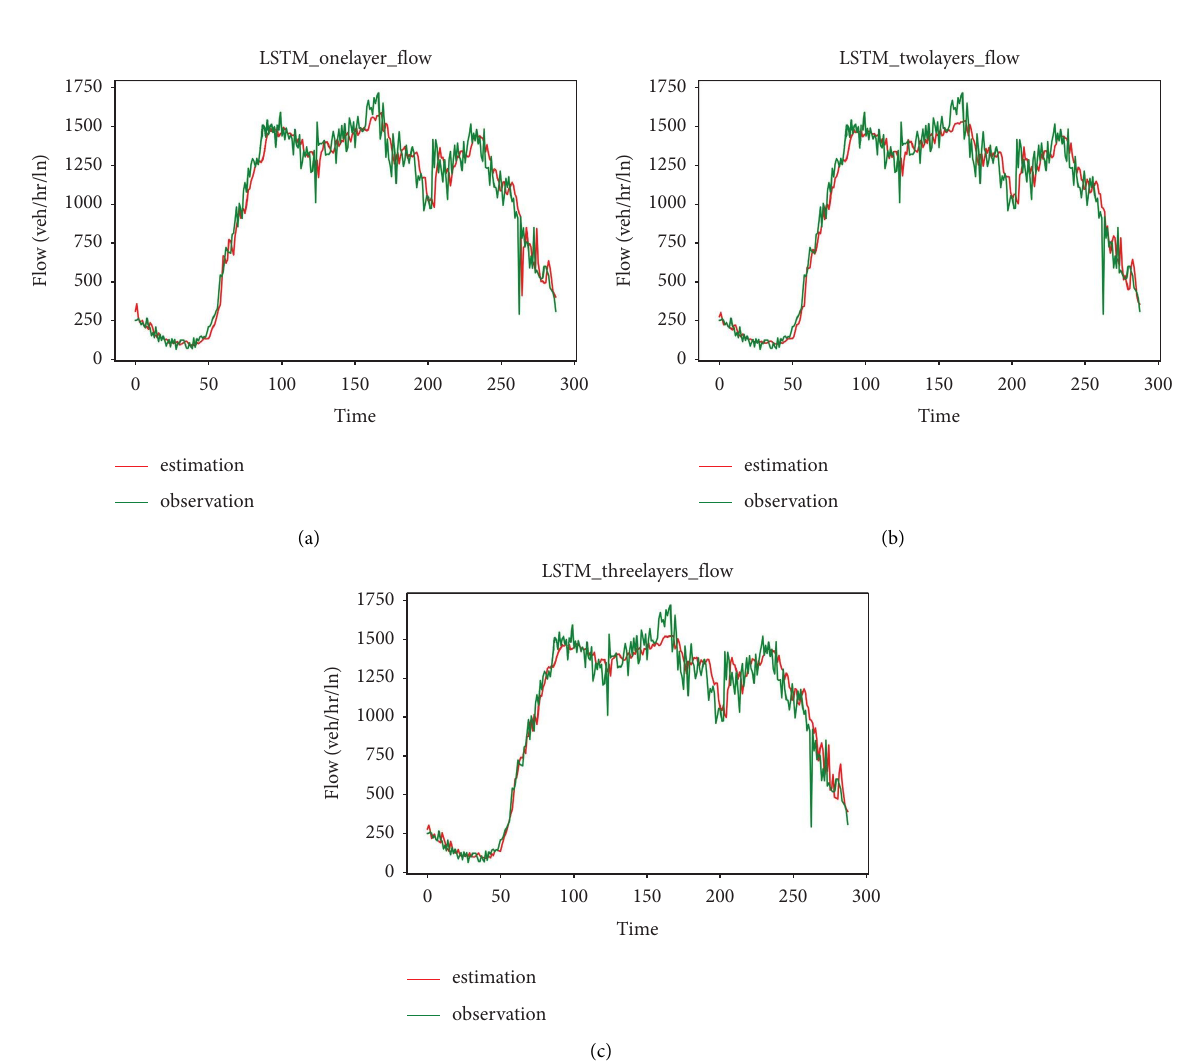
Figure 7: Estimated fow by the data-driven method in the Los Angeles case. (a) one-layer; (b) two-layer. (c)